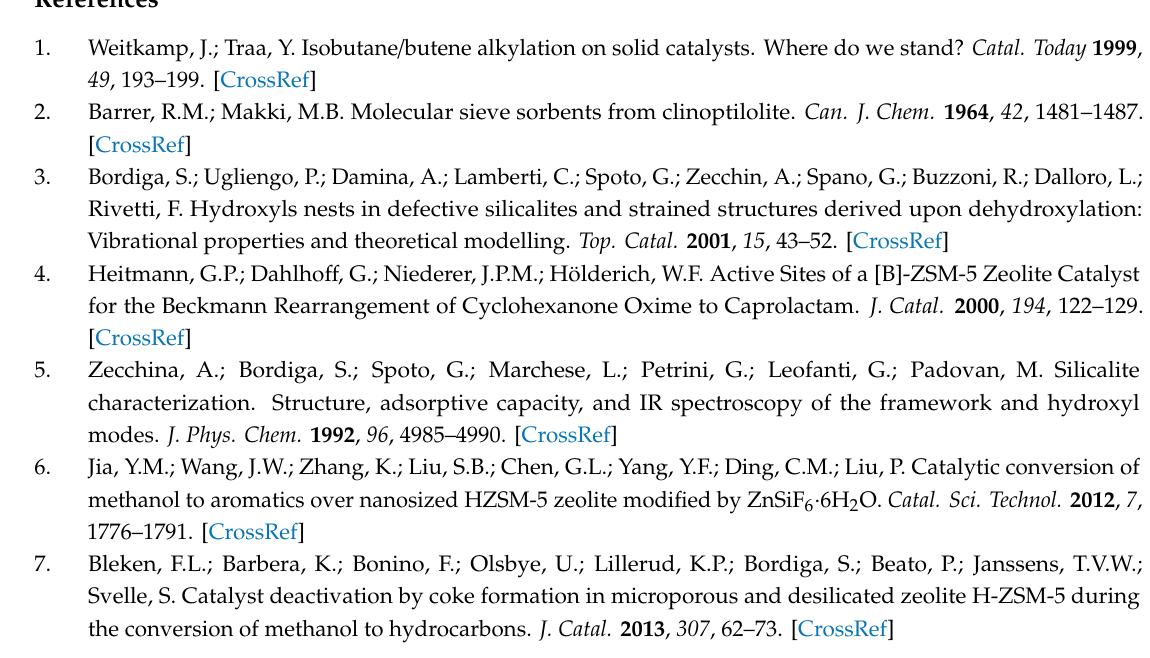
Figure S1: XRD profiles of ZnSnPt / MFI zeolites with di ff erent SiO 2 / Al 2 O 3 ratios. Figure S2: H 2 -TPR profiles of Sn or Pt modified defective MFI